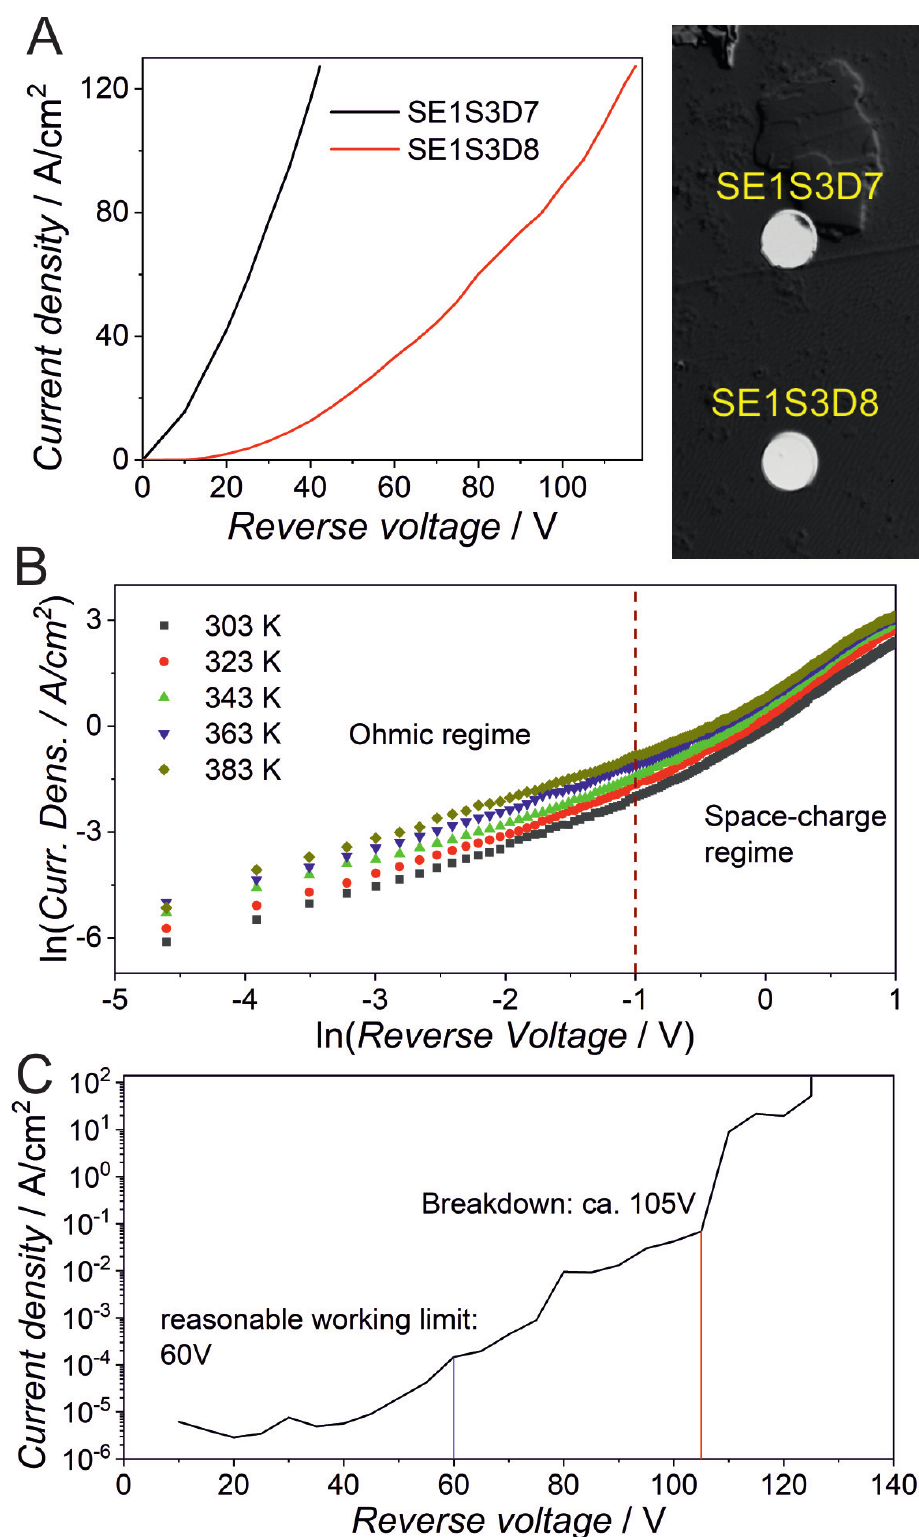
Figure 5. ( A ): Comparison of two diodes from sample III, where the upper diode on the pene- tration twin has a much stronger leakage current despite being further away from the p + region; ( B ): temperature-dependent leakage current density measurements of one of the diodes on sample II with a low-voltage ohmic regime and a space-charge regime at higher voltages; ( C ): breakdown measurement for the diode on sample I from Figure